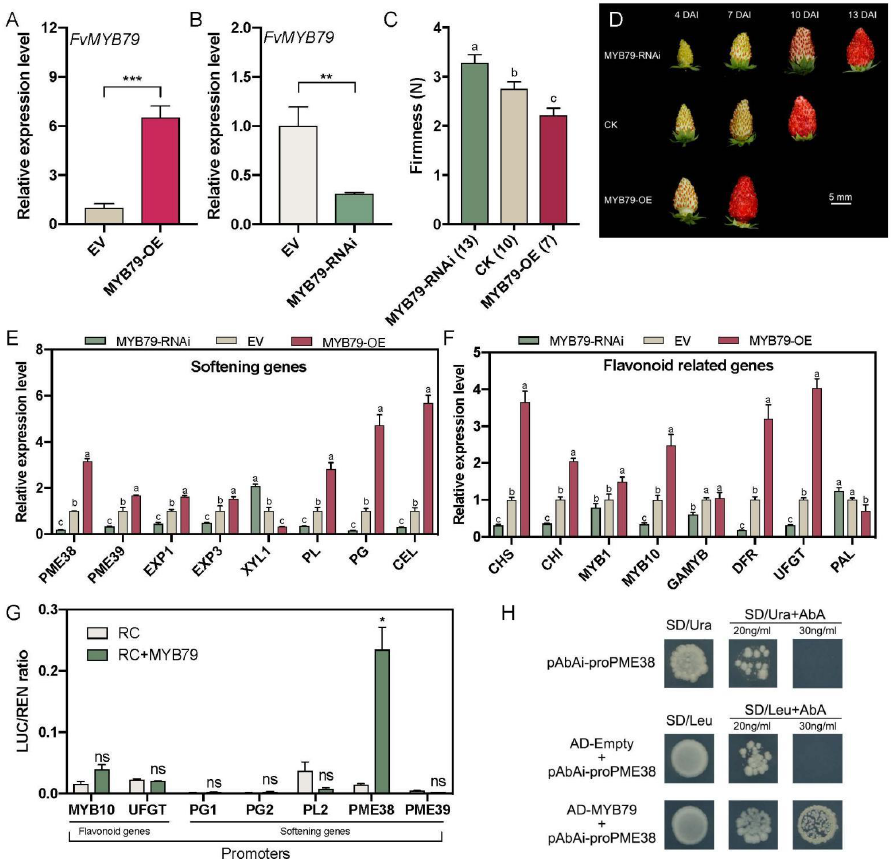
Figure 4. FvMYB79 positively regulates fruit softening. ( A , B ) Q-PCR analysis of transcript levels for FvMYB79 in overexpression and RNAi fruits at three days after injection. Error bars represent SD of three independent replicates. Asterisk indicates values that were determined by the t -test to be significantly different from the control (**, p < 0.01; ***, p < 0.001). ( C ) Firmness value of overexpression and RNAi fruits at same ripening stages after infiltration. The number in bracket of x-axis labels represents the number of days after injection. Error bars represent SD of 15 fruits. Letter indicates significant differences between groups ( p < 0.05, one-way ANOVA, Tukey’s HSD post hoc test). ( D ) Phenotypes of fruits were agro-infiltrated with FvMYB79 overexpression and RNAi constructs, respectively. DAI, day after infiltration; EV, empty vector; RNAi, RNA interference; OE, overexpression. ( E , F ) Expression assay of flavonoid and softening related genes in fruits of transient overexpression or silencing of FvMYB79 . Relative expression levels of each gene were normalized to internal control Fvactin . Error bars represent SD of three independent replicates. PME, pectin methylesterase; EXP, expansin; XYL, beta-xylosidase; PL, pectate lyase; PG, polygalacturonase; CEL, cellulose; CHS, chalcone synthase; CHI, chalconeisomerase; DFR, dihydroflavonol 4-reductase; UFGT, UDP-glucose flavonoid 3-O-glycosyltransferase; PAL, phenylalanine ammonialyase. ( G ) Validation of activation effect of FvMYB79 on the promoter of flavonoid and softening related genes. Tobacco leaves were transfected with a reporter construct alone (RC) or together with the FvMYB79 effector construct (RC + MYB79). LUC, firefly luciferase; REN, renilla luciferase. Asterisk indicates values that were determined by the t -test to be significantly different from the control (*, p < 0.05). ( H ) The interaction between FvMYB79 and the FvPME38 promoter. Autoactivation was tested on SD/-Ura in the presence of 20 and 30 ng/mL aureobasidin A (AbA). Physical interaction was determined on SD medium lacking Leu in the presence of 20 and 30 ng/mL AbA. The empty pGADT7 vector was applied as a negative